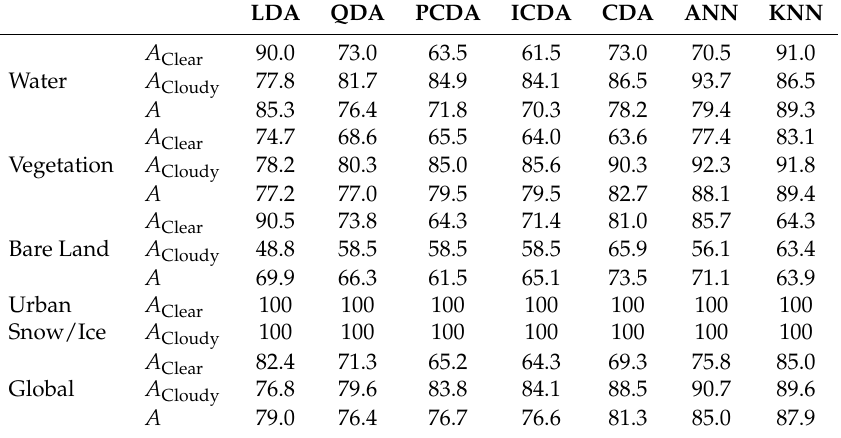
Table 8. Accuracy indicators A , A Clear and A Cloudy of classification methods of Section 3 when validation is made on the gold standard dataset of Section 2.2 and classifications are separate for each climatic zone. Percentage values are reported for the entire dataset (row Global) and for the different surface